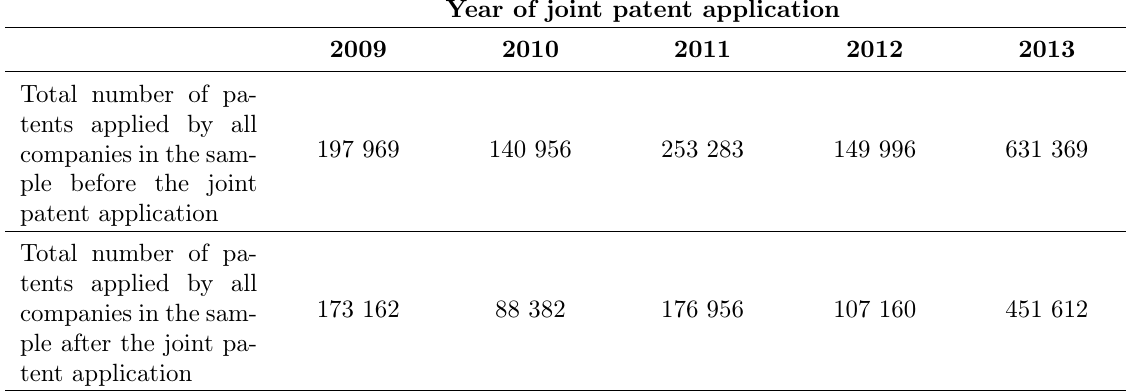
Table 3. Patent portfolio sample